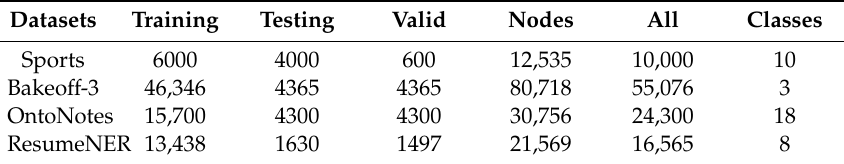
Table 2. Summary of the statistics of di ff erent datasets.